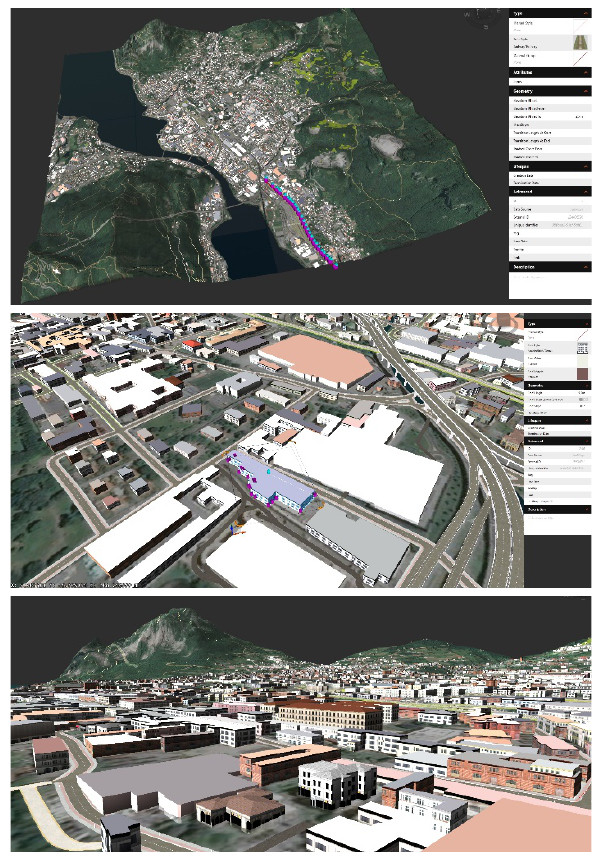
Figure 7. Some images of the geospatial data retrieved and imported in a BIM environment for further